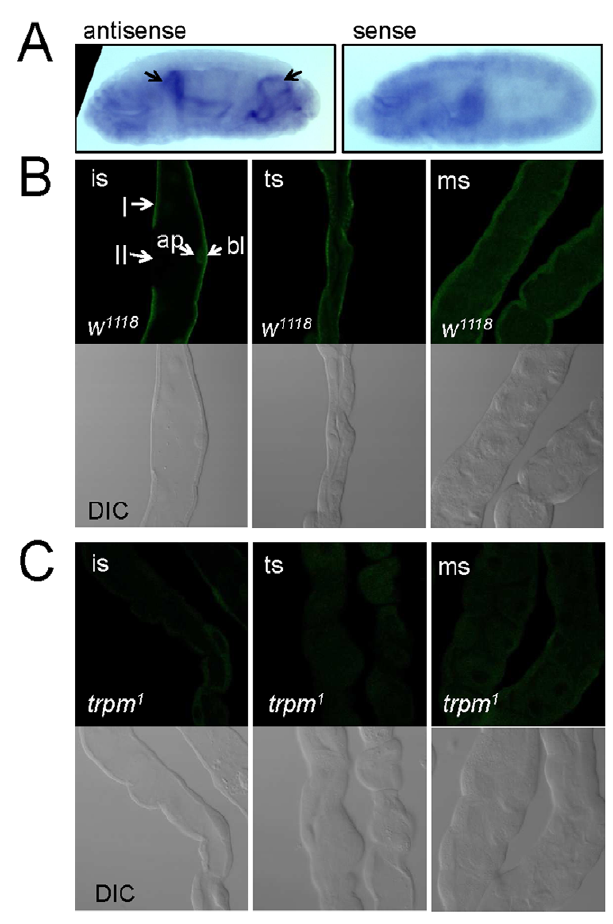
Figure 5. Expression of trpm in Malpighian tubules. (A) Detection of trpm RNA in Malpighian tubules of stage 16–17 embryos by in situ hybridization. Arrows indicate the localization of the anterior and posterior Malpighian tubules in the left panel using the antisense probe. (B) Malpighian tubules from w 1118 3 rd instar larvae stained with TRPM antibodies. (C) Malpighian tubules from trpm 1 3 rd instar larvae stained with TRPM antibodies. Abbreviations: ms=main segment, ts=transitional segment, is= initial segment, I=type 1/principal cell, II= type 2/stellate/bar-shaped cell. The stainings of the epithelial apical (ap) and basolateral compartments are indicated.